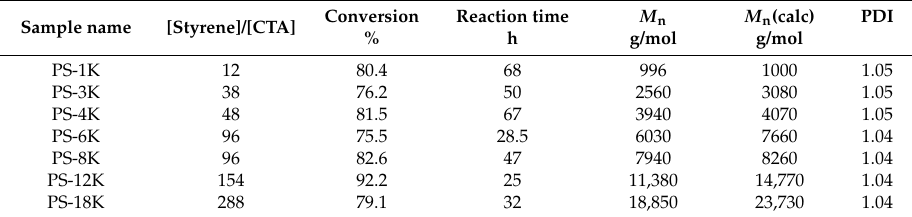
Table 1. Summary of the reaction conditions of the different polystyrene